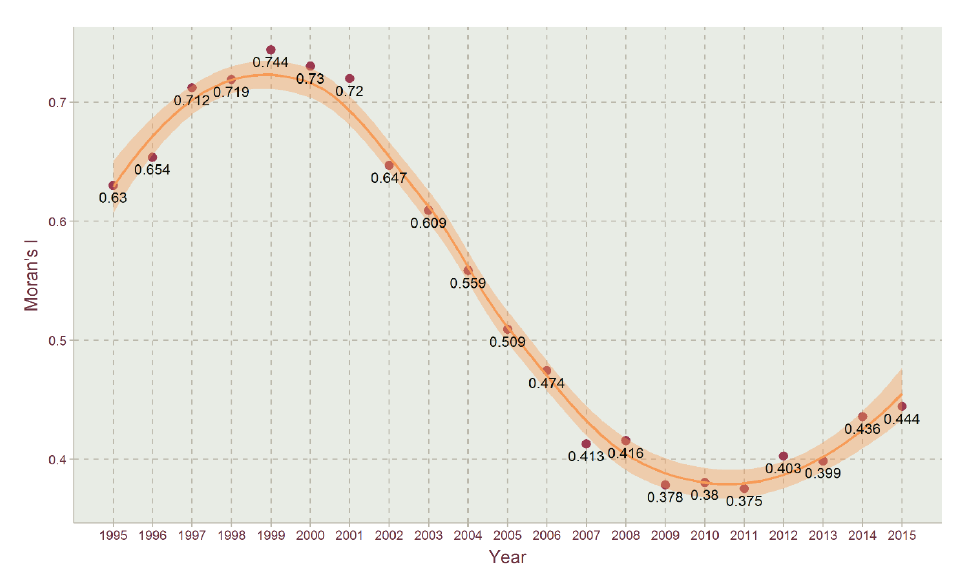
Figure 10. Temporal c hanges in Moran’s index (I) of Jiangsu’s EFI in 1995– 2015.